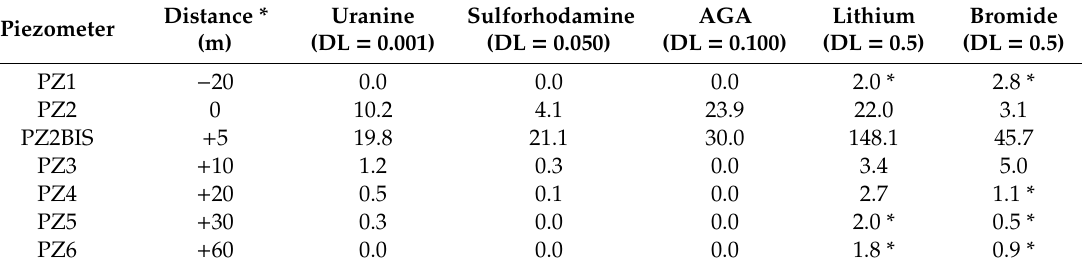
Table 6. Maximum net tracer concentration per piezometer (in µ g · L − 1